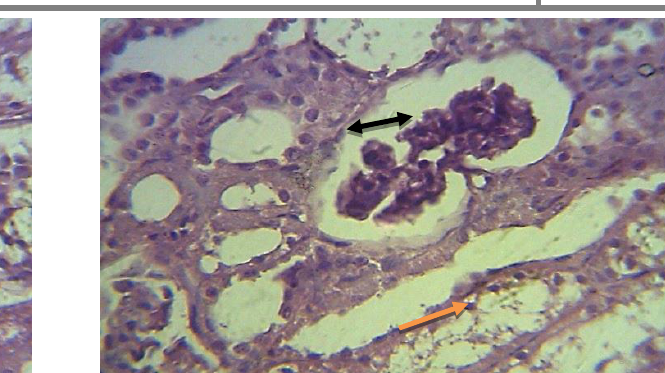
Fig.7: Kidney of T2 animal at 42day post treated shows vacuolar degeneration of epithelial lining cells of renal tubules and mononuclear cells infiltration between renal tubules (H and E stain 40x).